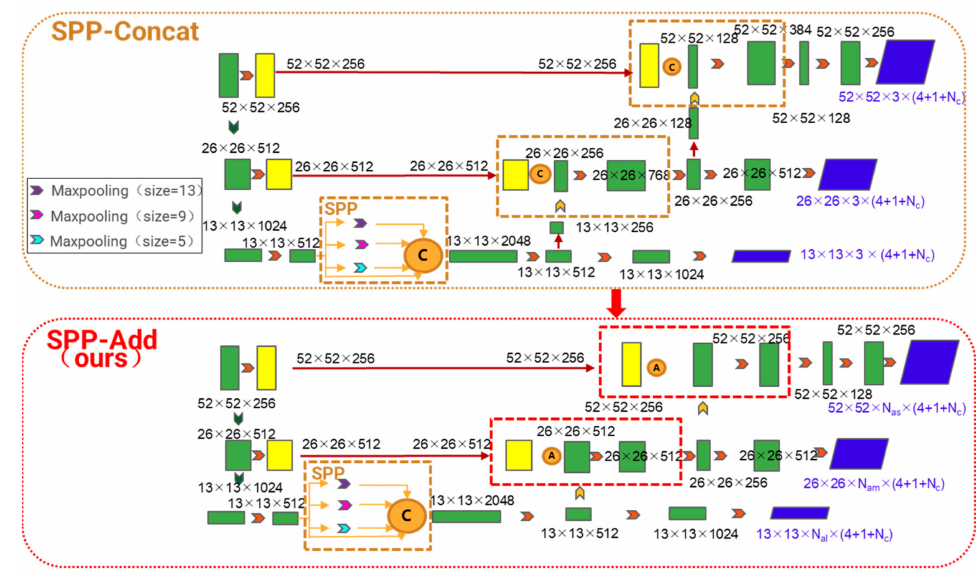
Figure 5. Addition fusion strategy for multi-scale imbalanced features based on